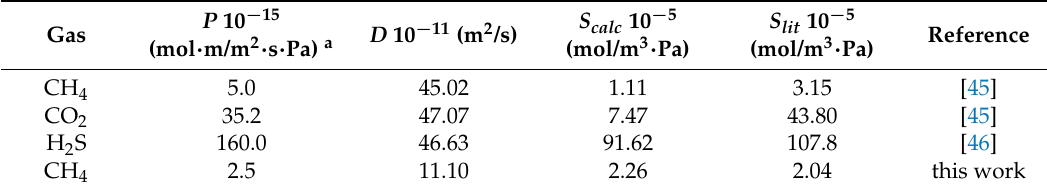
Table 3. Diffusivities ( D ) of various gases in the ILs at 298 K, the gas solubility’s based on the literature ( S lit ) and calculated ( S calc ) data, and the gas permeabilities ( P ). P 10 − 15 Gas (mol · m/m 2 · s · Pa)